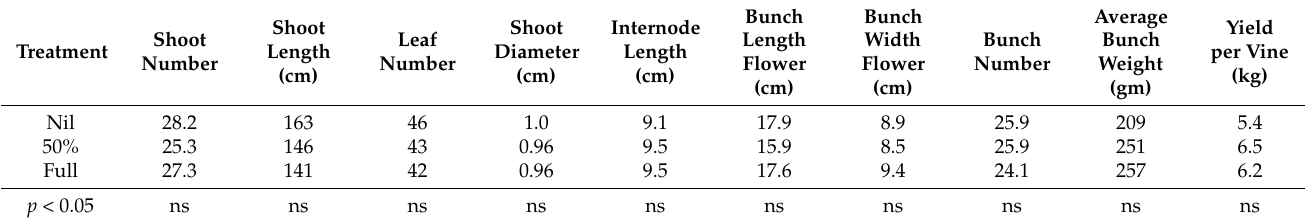
Table 2. Vine performance measures at fruit set and harvest for Xynisteri, field trial, Kato Mylos, Cyprus, 2019 growing